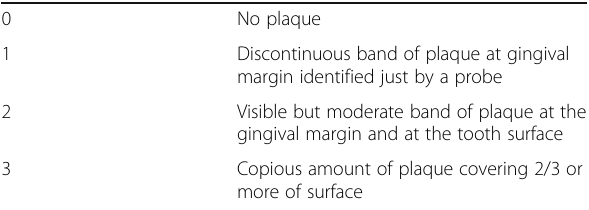
Table 2 Plaque index (PI)